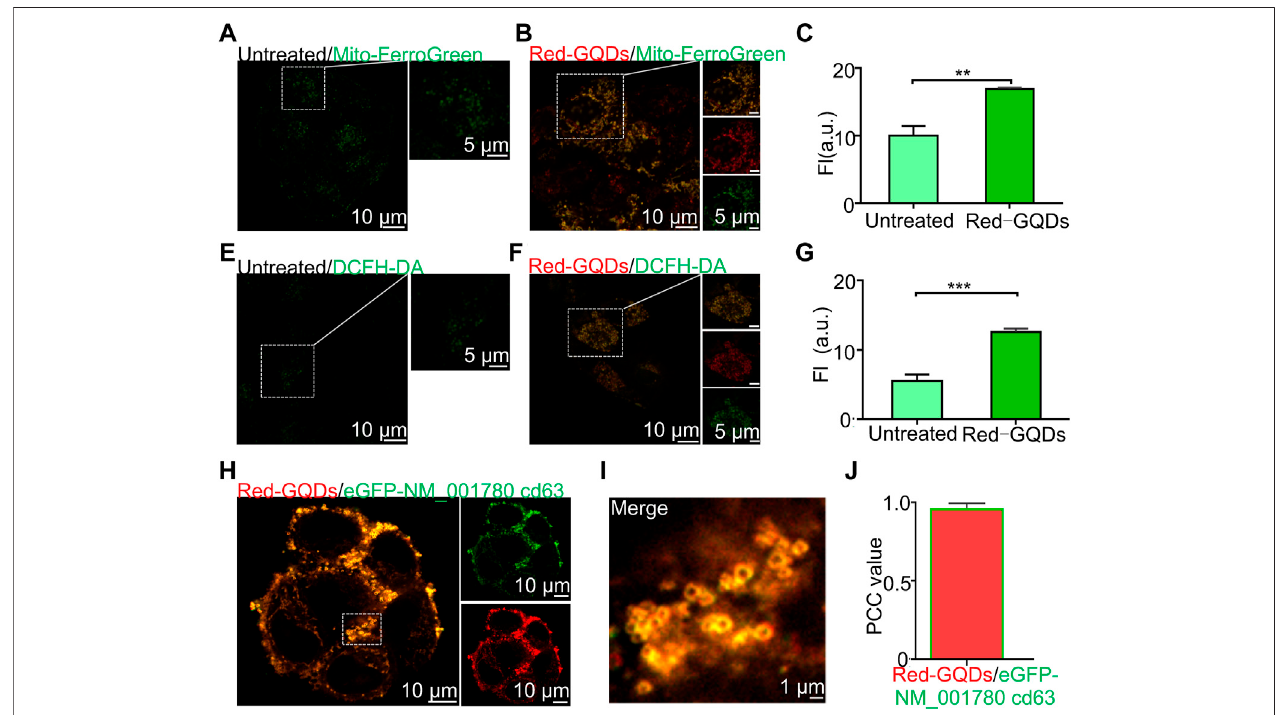
FIGURE 4 | Red-GQDs of higher concentration induce ferroptosis and exosome secretion. (A,B) Fluorescence image of mitochondrion Fe 2+ with and without treated with Red-GQDs (50 μ g/ml, 1 h), Mito-FerroGreen: λ ex = 488 nm. (C) Mitochondrion Fe 2+ level with and without Red-GQD s (50 μ g/ml, 1 h)-treated. (E and F) Fluorescence image of mitochondrion ROS with and without Red-GQDs (50 μ g/ml, 1 h), DCFH-DA: λ ex = 488 nm. (G) Mitochondrion ROS level with and without Red- GQDs (50 μ g/ml, 1 h)-treated. (H) Co-localization of Red-GQDs (50 μ g/ml, 1 h) and commercial exosomes probes eGFP-NM_001780 cd63 ( λ ex = 488 nm). (I) Fluorescence image of the enlarged region indicated by the white rectangle in (H) . (J) Co-localization value of Red-GQDs and eGFP-NM_001780 cd63. Data are presented as mean ± SEM ( n =